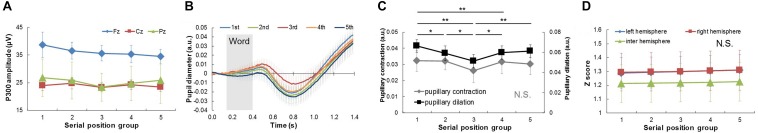
Physiological responses extracted from EEG and pupil diameter signals among five serial position groups in middle time-scale comparison. (A) Comparison of P300 amplitude among serial position groups. (B) Average response waveforms of pupil diameter signals for five serial position groups. Gray rectangle represents duration of word presentation. (C) Comparison of pupillary contraction and dilation among serial position groups. Bars represent standard errors. (D) Comparison of functional connectivity among serial position groups. N.S., not significant. ∗p < 0.05 and ∗∗p < 0.01.